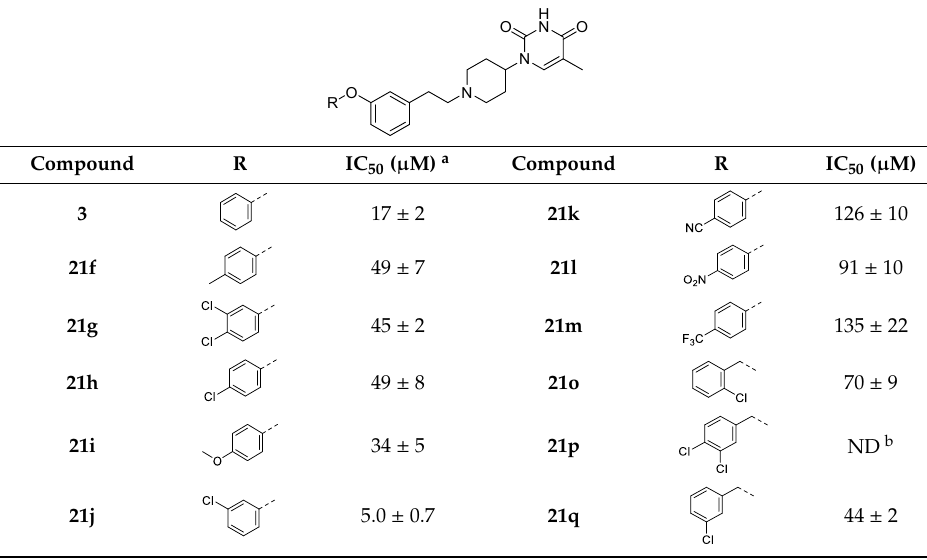
Table 2. Mtb TMPK inhibitory activity of the compounds.